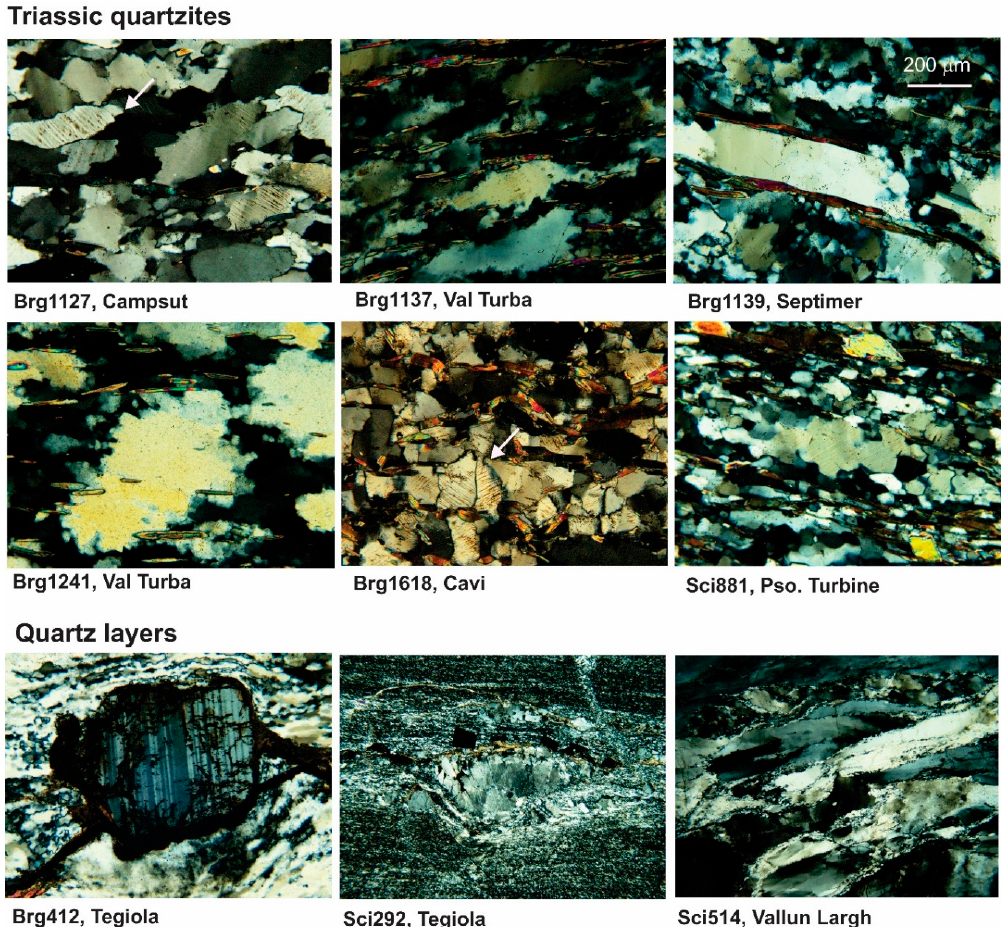
Figure 5. Optical images of selected samples at high magnification. Crossed polarizers. Scale indicated at top right. Clasts in Brg412 and Sci292 are plagioclase, colored phases are muscovite. White arrows in Brg1127 and Brg1618 point to well visible deformation lamellae.